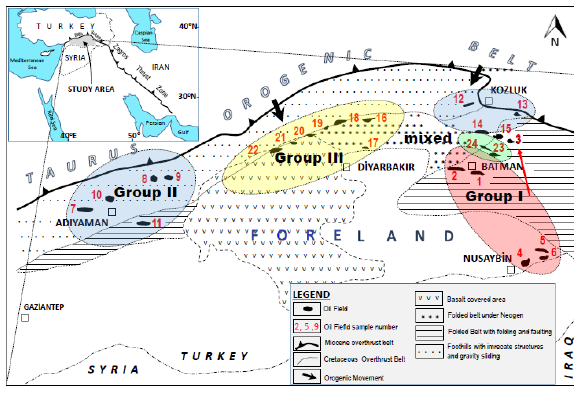
Figure 1. Location map SE-Turkey and collected crude oil samples from 24 different oil fields. Genetic grouping of the oils on the basis of this study is also